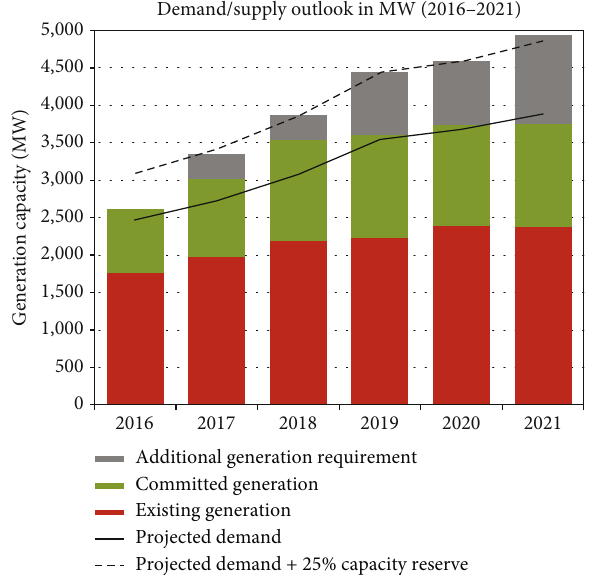
Figure 2: Energy Commission demand-supply projections,